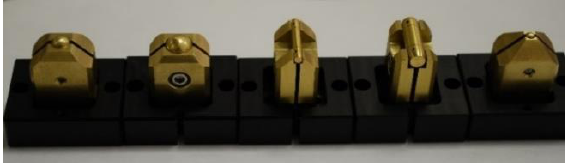
Figure 5. Various shapes of connectors that have similar contact interfaces.